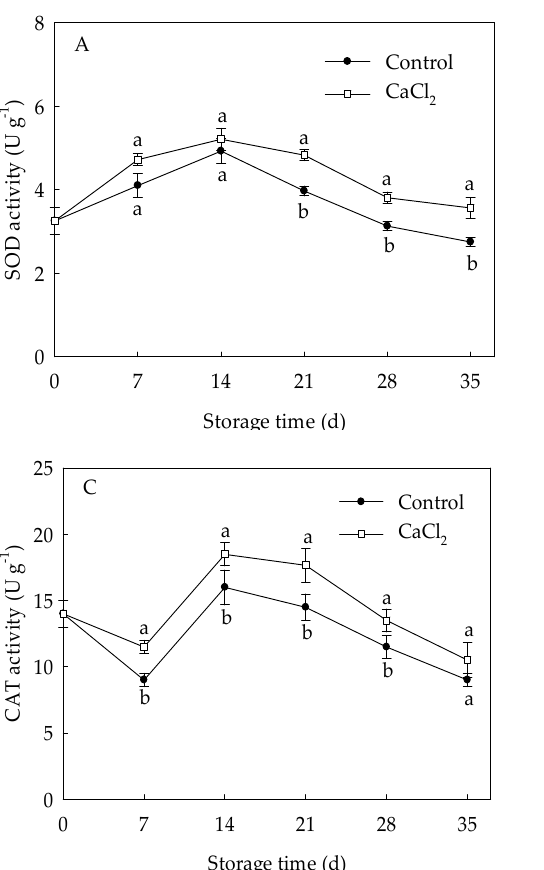
Figure 4. SOD activity ( A ), EjSOD expression ( B ), CAT activity ( C ) and EjCAT expression ( D ) in loquat fruit stored at 1 °C after treatment with 1% CaCl 2 or water (control). Vertical bars indicate the SE of mean ( n = 3). The symbols a and b represent a significant difference in the two treatments ( p < 0.05).